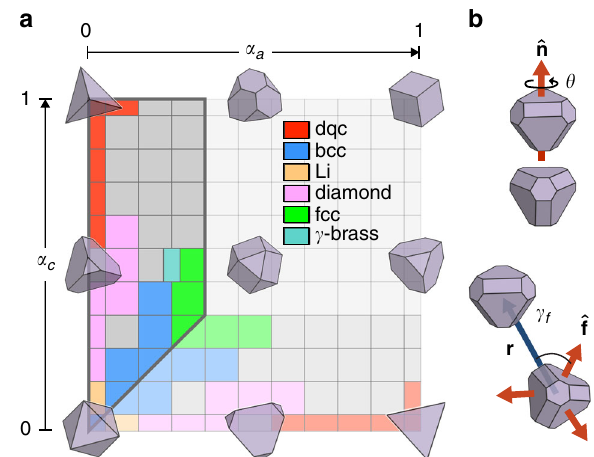
Fig. 1 Shape space and motif analysis methods. a The spheric triangle invariant 323 family, with the portion of the shape space explored in this study outlined. The remaining region is colored a light gray; for details on self-assembly behavior in this region, see Damasceno et al. 27 and Klotsa et al. 29 Sample particle shapes are overlaid above corresponding regions of shape space, and regions are colored according to the assembled structure of the corresponding particle shape at densities between ϕ = 0.48 and ϕ = 0.64. At ( α a , α c ) = (0, 0.2), the system assembles into a compressed derivative of diamond with lower symmetry, but that region is colored identically to the other (cubic) diamond-formers to emphasize the similarity of these structures. At ( α a , α c ) = (0.3, 0.3), assembly into bcc occurs at ϕ = 0.64, while assembly into fcc occurs at lower densities; we color this region by the structure it assembles at the lowest density. For a broad swath of the highlighted landscape, colored gray, assembly fails to occur at any investigated density. b Characterization of local pairwise motifs. θ denotes the minimal angle associated with the rotation (about b n ) that orients a particle identically to its nearest neighbor. γ denotes the minimal angle associated with the projection of r onto the set of unit vectors pointing to some feature of the non-truncated version of the particle shape. In this example, vectors point to centers of the faces of the non-truncated particle shape, and γ f is the angle associated with the projection onto b